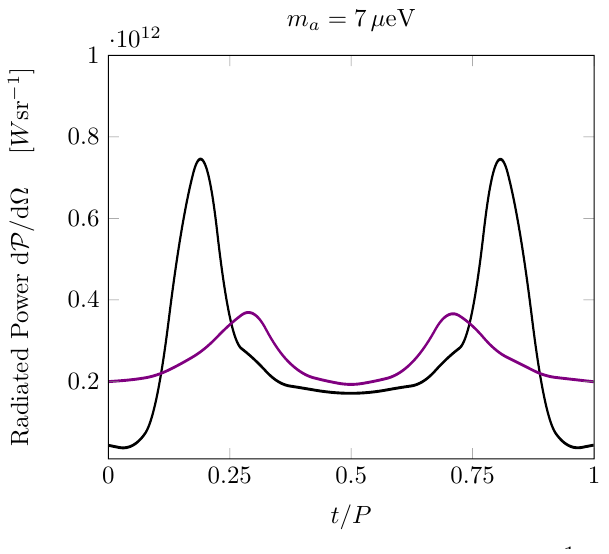
Figure 8 . Effect of Gravity on Pulse Profiles. Pulse profiles with r s /R = 0 . 29 (purple) and r s /R = 0 . 03 (black) for an axion mass m a = 7 µ eV and an observing angle θ = 36 ◦